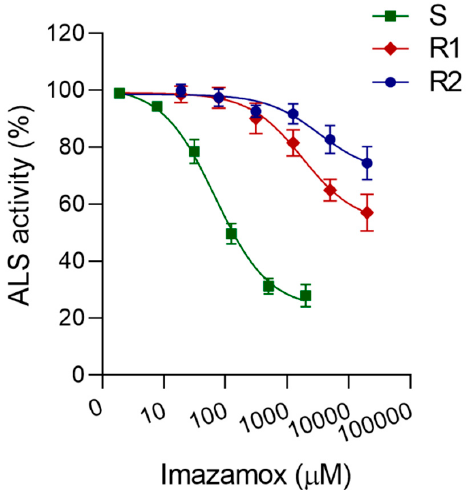
Figure 2. Acetolactate synthase (ALS) enzyme activity in two imazamox-resistant ( R ) and one susceptible ( S ) wild poinsettia ( Euphorbia heterophylla ) populations in response to increasing imazamox concentrations. R1 is also resistant to PPO-inhibiting herbicides and R2 is also resistant to glyphosate. Model fit: y = a/[1 + (x/c) b ]. Error bars represent the standard error of the means ( n = 6).